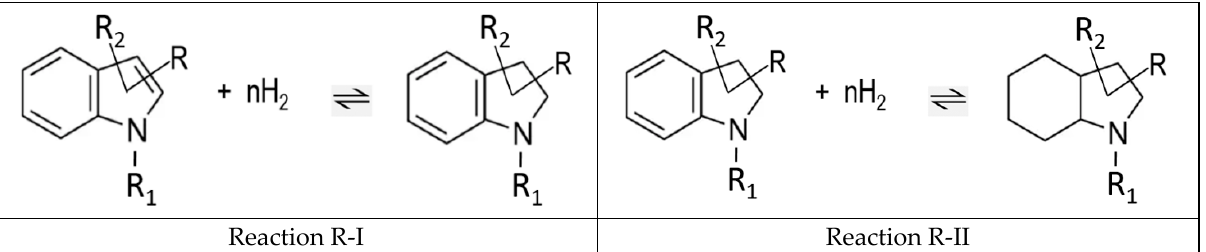
a The G4 calculated values from Table 3. b Evaluated values from Table 5. c Calculated according to Equation (2).